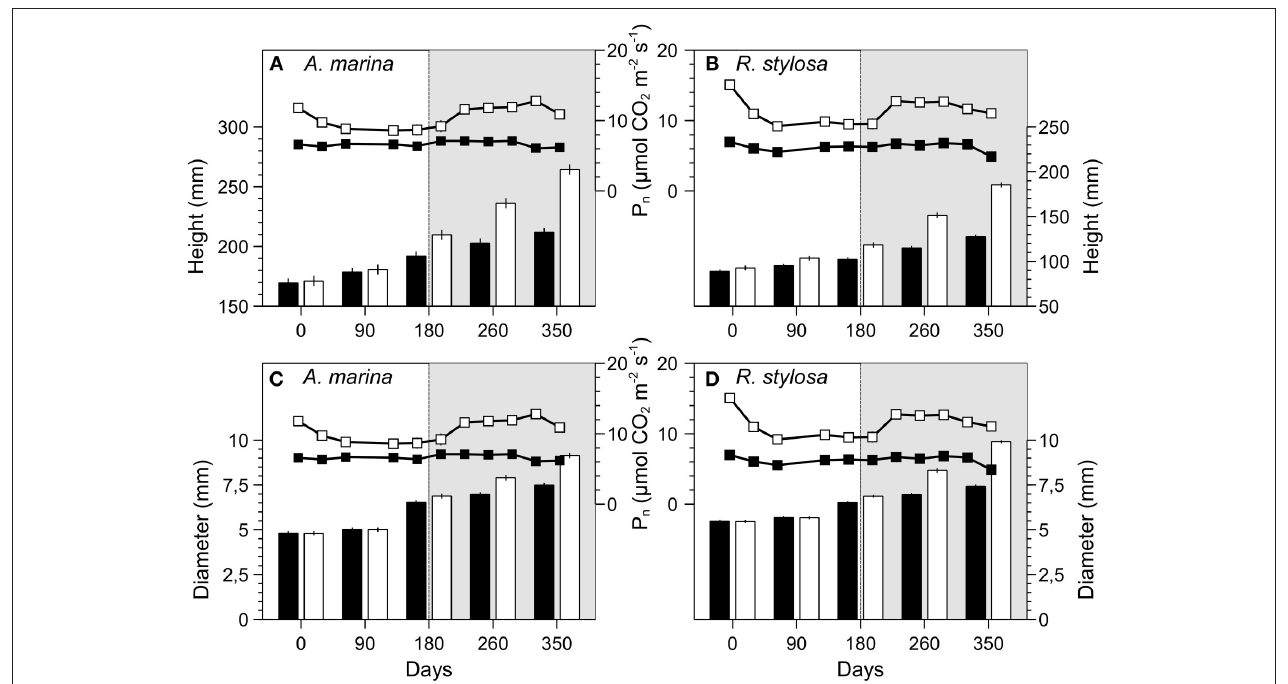
FIGURE 4 | Heights (mm), diameters (mm) and photosynthesis ( µ mol CO 2 m − 2 s − 1 ) of A. marina (A,C) and R. stylosa (B,D) grown in ambient (black bars and markers) or elevated CO 2 (white bars and markers) for 12 months. Values are means ± SEM (Heights and diameters: A. marina n = 125; R. stylosa n = 180; photosynthesis: n = 30). The white and shaded area correspond respectively to the cool and the warm seasons. Photosynthesis data are from Jacotot et al. (2018).